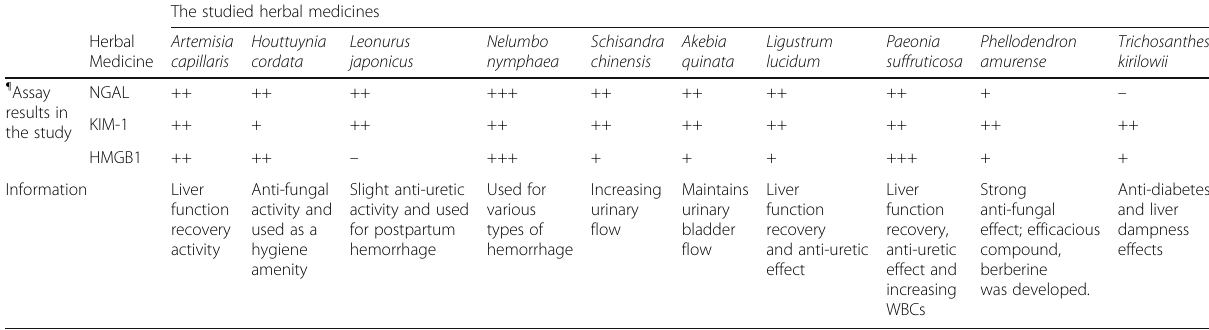
Table 1 Comparative properties and known information on the studied herbal medicines regarding acute kidney injury The studied herbal